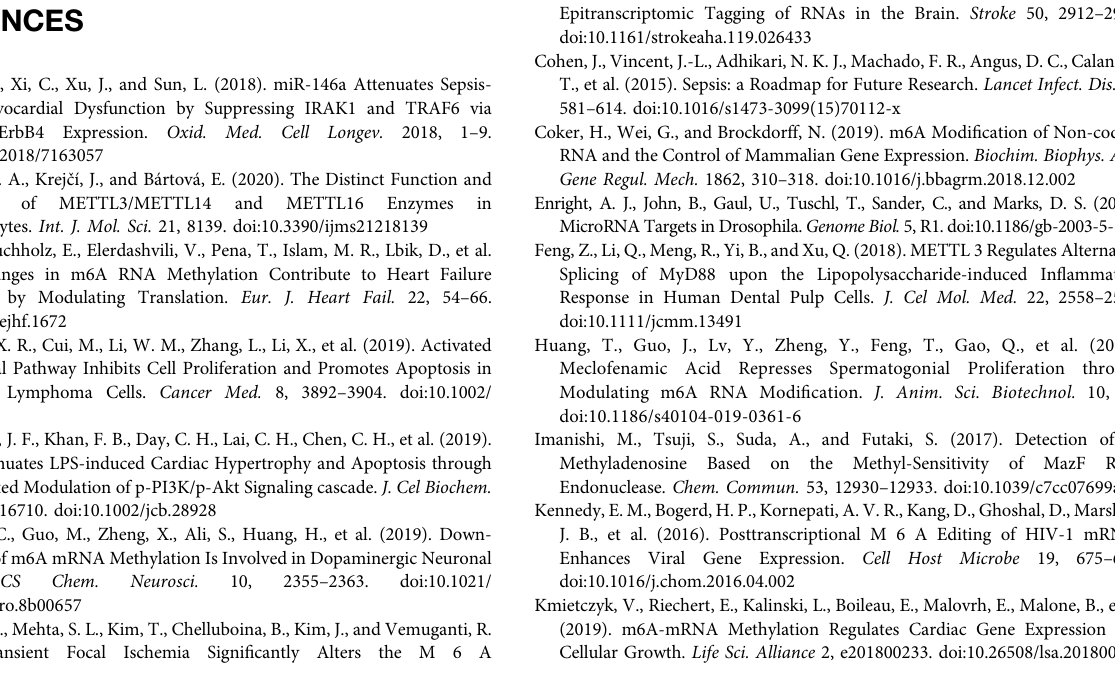
Supplementary Figure 1 | Expressions of m 6 A-related enzymes were detected by western blot analysis. n (cid:1) 3-4; * P < 0.05. Ctrl, control; LPS, lipopolysaccharide. Supplementary Table 1 | Sequence of primers used for qRT-PCR analysis of mRNA